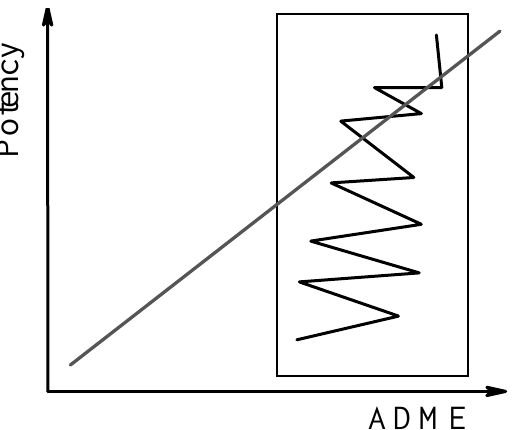
Figure 2. Second scenario: The optimisation of binding affinity (potency) is performed starting from an ADME-filtered region (box) of the medicinal chemistry